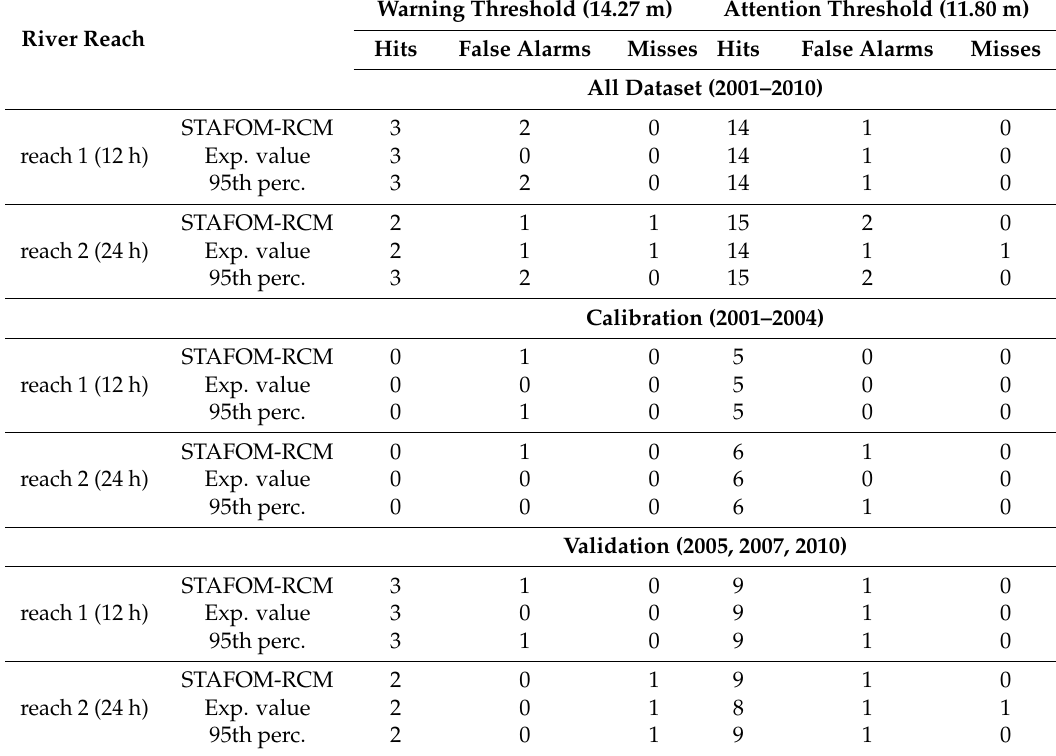
Table 6. Contingency tables showing the capability of STAFOM-RCM and of the expected value and the 95th percentile provided by MCP-MT in hydrometric thresholds exceedance/non-exceedance